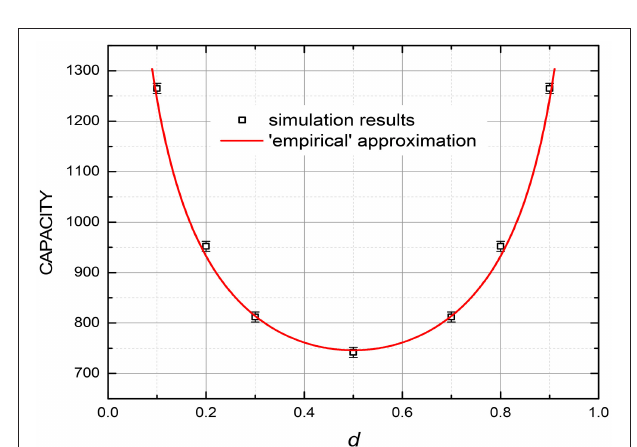
FIGURE 7 | The probability of the retrieved movie’s corruption at the analog FIGURE 9 | The capacity (at 99% fidelity) at the discrete gradient-descent gradient-descent recording (The lines are only guides for the eye). N 101 = × recording, as a function of the “duty cycle” d , i.e., the fraction of binary pixels 101 10,201, M 21 21 – 1 440, η 10 − 3 . The recording iterations = = × = = having a certain binary value in each frame, for M (Equation 5) were stopped either after 10 5 epochs, or when the magnitude of shows the empirical dependence Q max all errors (Equation 6) dropped below 0.1. The error bars represent the represent the estimated maximum standard deviation of the mean based on 100 simulations.